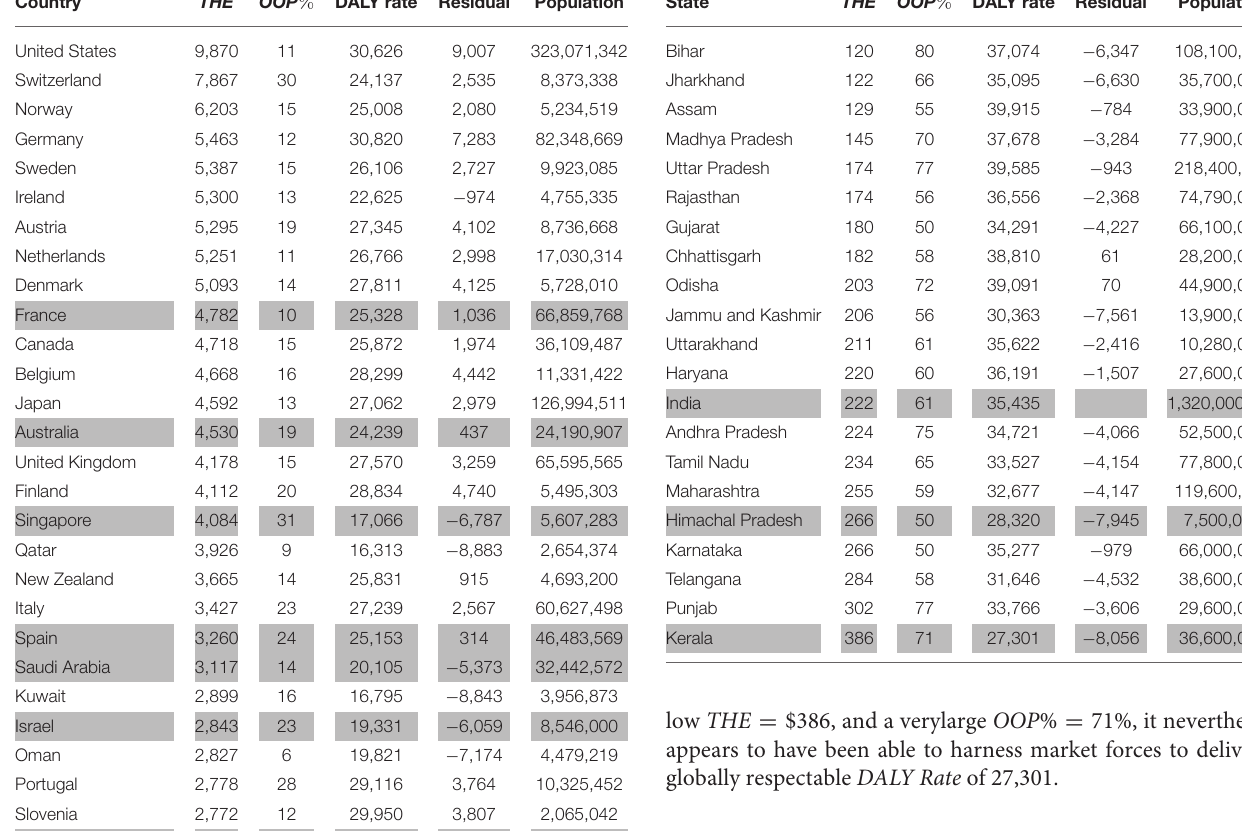
TABLE 9 | Rich countries with THE > $ 2,500. Country THE OOP % DALY rate Residual Population